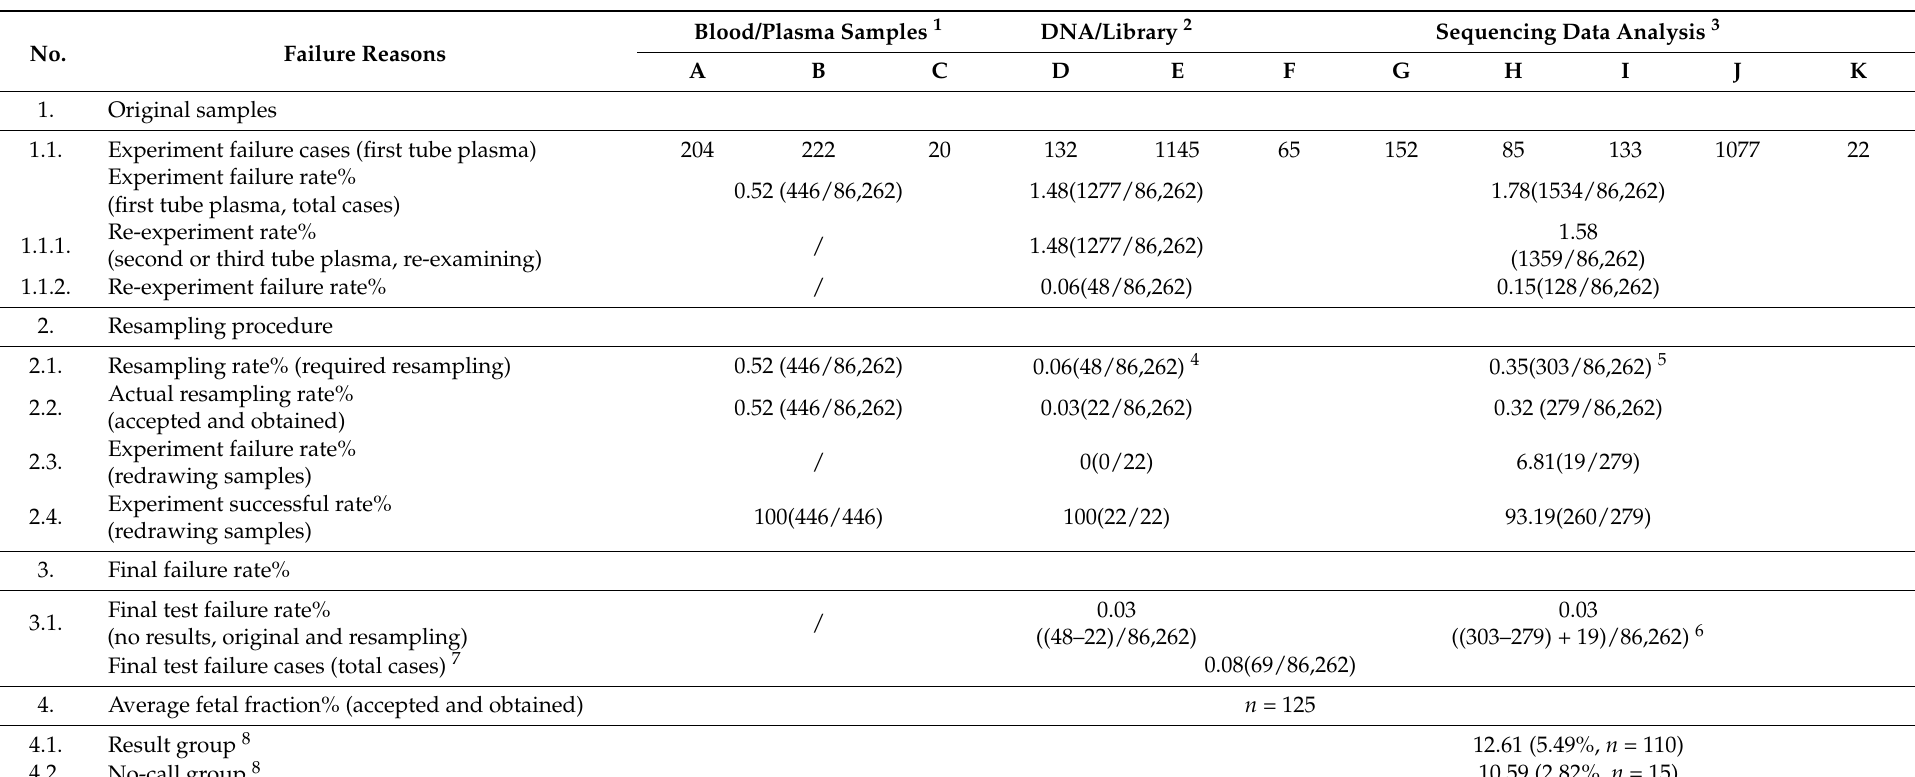
Table 2. Information of detection failure on the originally submitted and resubmitted